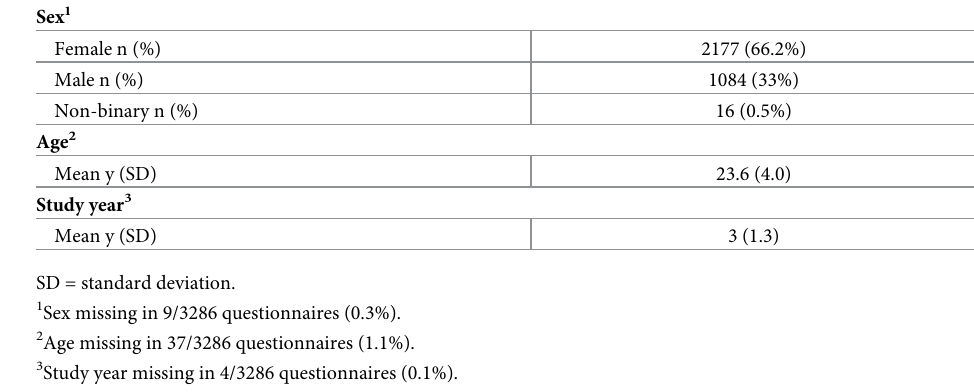
Table 1. Demographic characteristics of the